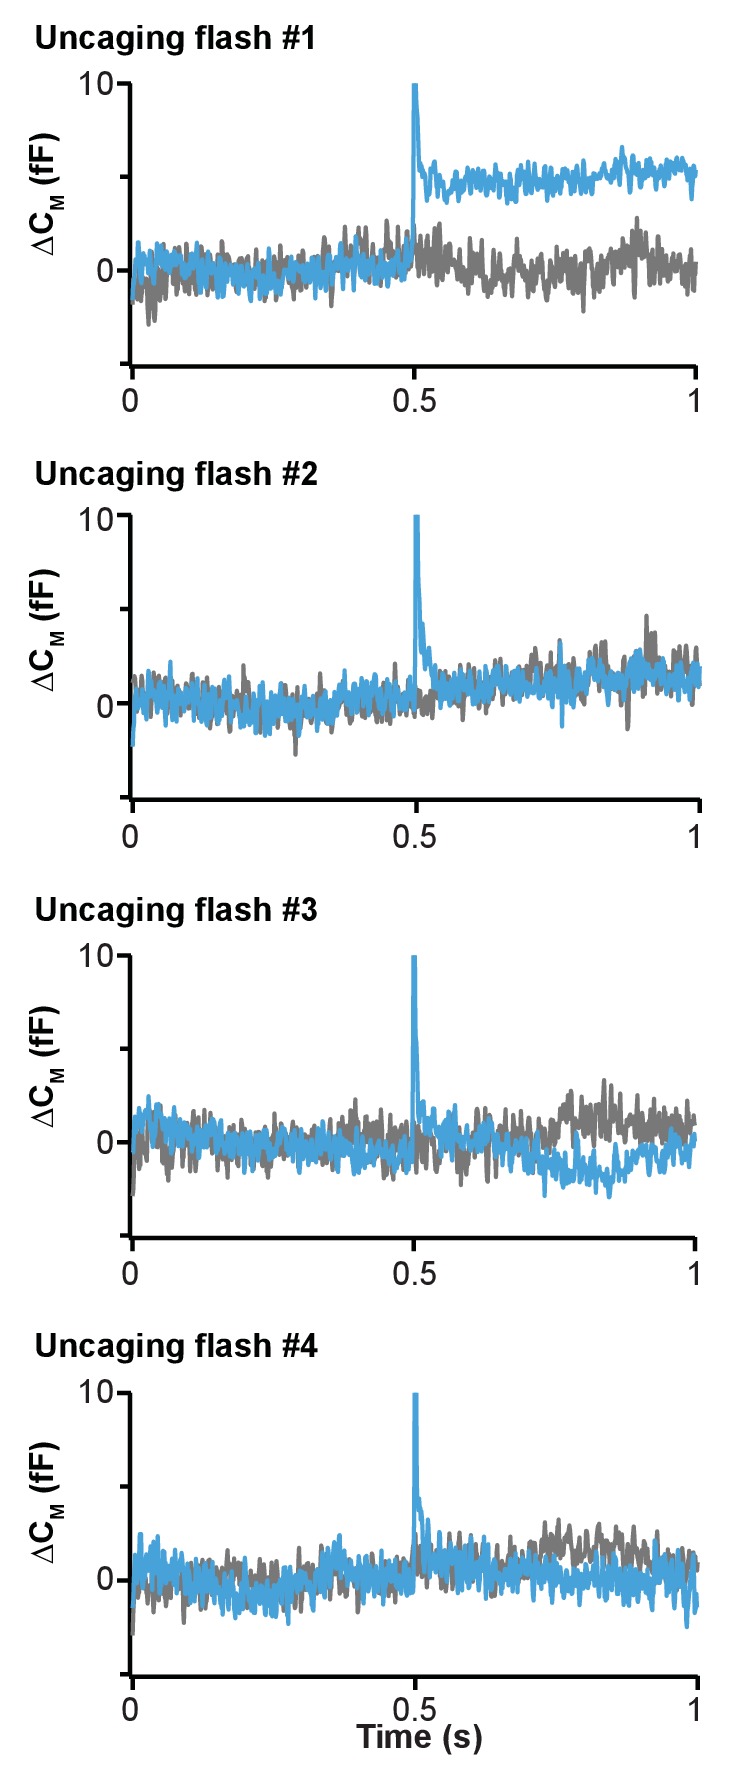
Fast release of vesicles upon first PI(4,5)P2 uncaging event in wild type chromaffin cells.Our uncaging protocol in chromaffin cells included four sequential uncaging pulses every 15 s. Figure 7 shows only the average capacitance traces during the first uncaging. Here, the membrane capacitance traces (means of all cells loaded with 1a,b) around the time of all four uncaging pulses (lasting 1–2 ms, see Methods) are shown. Light blue traces: wild type cells that were exposed to uncaging flashes; grey traces: wild type cells not exposed to uncaging flashes (same cells as in Figures 4 and 5). The uncaging flash was delivered in the middle of the trace (at 0.5 s). Note that the ‘spike’ in the blue trace is an electrical interference artifact due to the discharge of the flash lamp. At the time of the first flash, the capacitance jumped by ~5 fF, which corresponds to the fast fusion of ~5 vesicles. In subsequent flashes, no capacitance jumps were detected, indicating that the discharge of the flash lamp itself does not cause a capacitance jump. These data are consistent with fast fusion of vesicles triggered by PI(4,5)P2 uncaging.